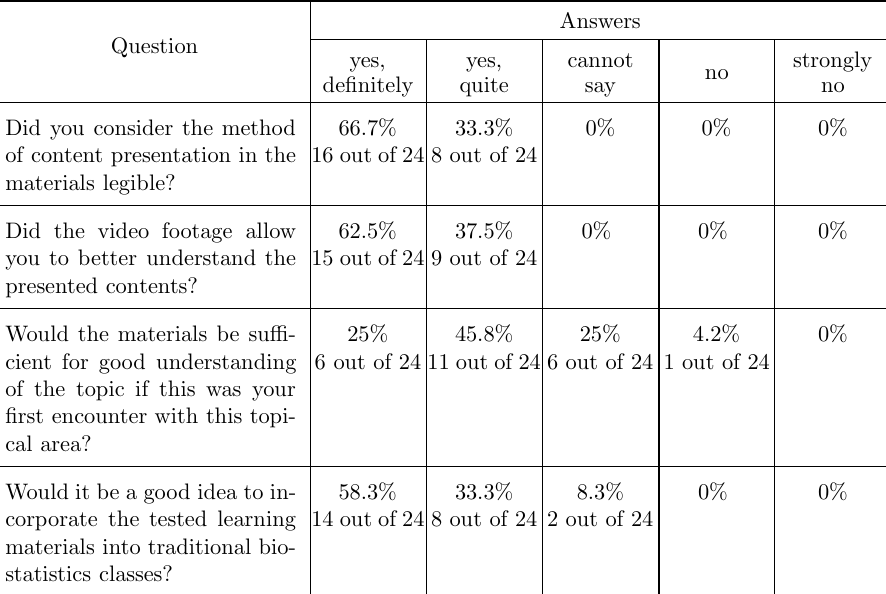
Table 1. Distribution of students’ answers to survey questions about the quality and usefulness of the